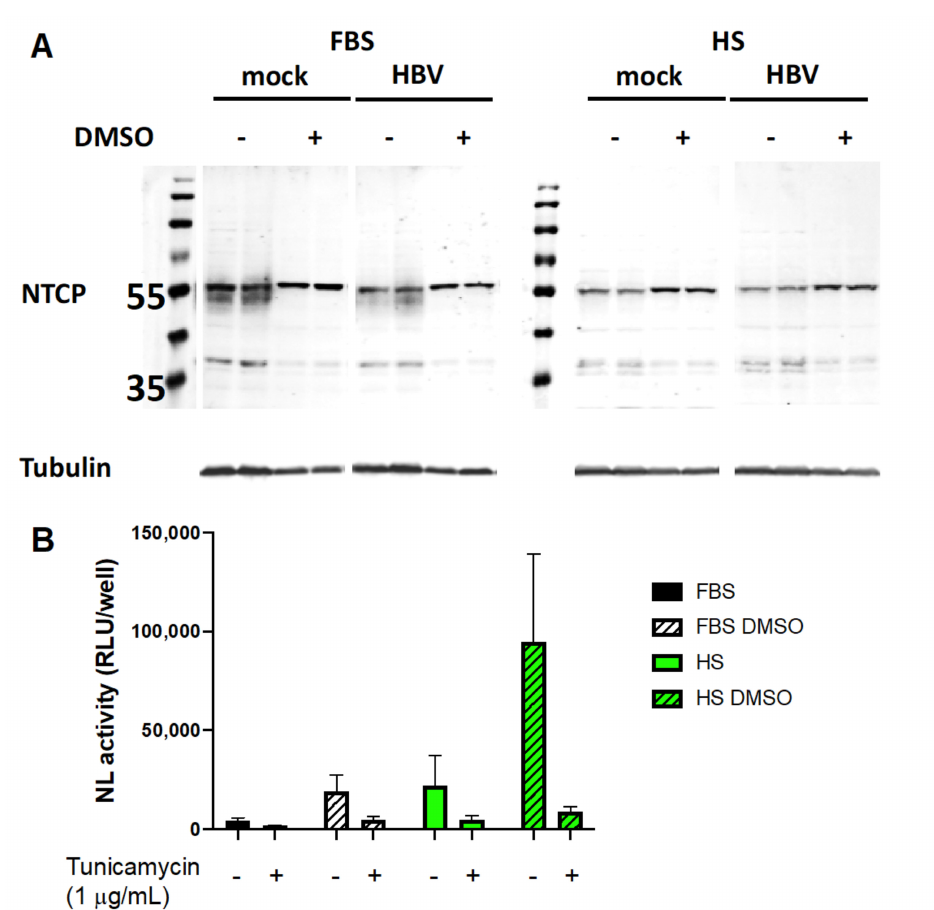
Figure 7. NTCP glycosylation and inhibition by tunicamycin. ( A ) Western blot analyses of NTCP glycosylation in Huh7.5- NTCP cells that were uninfected (mock) or infected with HBV. ( B ) Inhibition of N-glycosylation with tunicamycin suppressed HBV infection. Huh7.5-NTCP cells were incubated with 1 µ g/mL tunicamycin for 2.5 h, followed by washing four times with PBS prior to infection. The cells were infected with nanoluciferase-expressing HBV (HBVNL) (MOI 500). Luminescence in relative light units (RLU) per well was measured to indicate nanoluciferase (NL) activity. Average values with error bars ( ± SD) derived from three experiments are